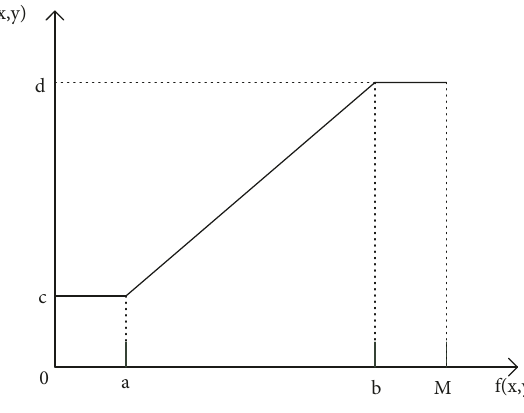
Figure 1: Linear transformation of gray